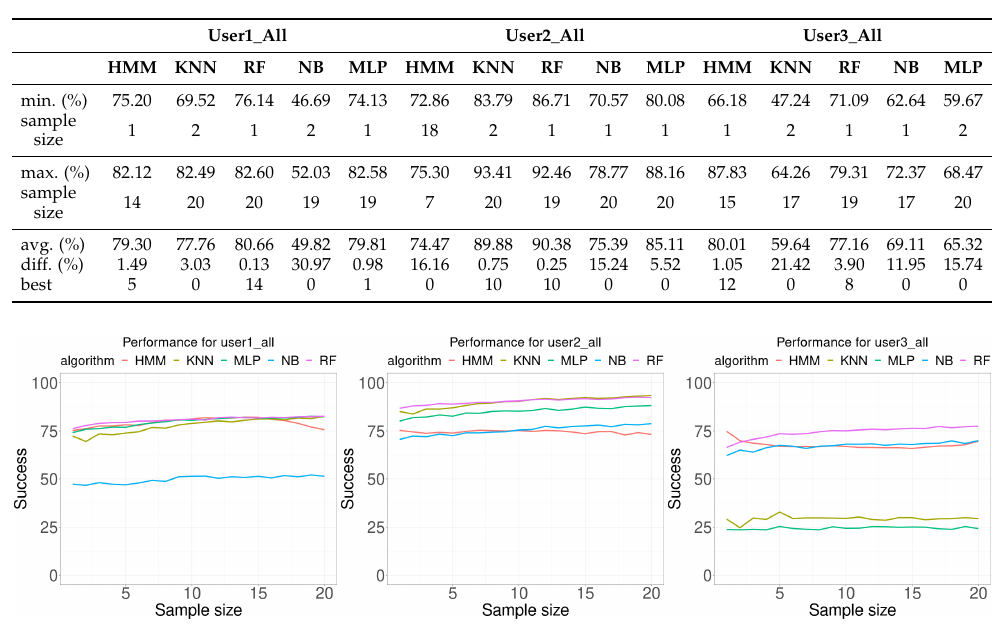
Figure 10. Performance comparison. Each curve plots the successful rate (percentage) as a function of the number of consecutive samples used for classification (sample size). Each Wi-Fi database contained 300 samples per room for building the model (100 at the center of the room, 100 from random walking, and 100 in the most common location in the